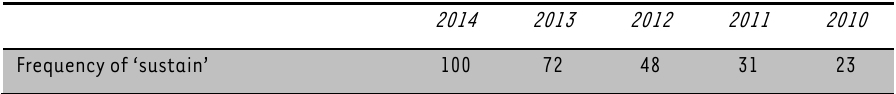
TABLE 5: SPAR sustainability frequencies from 2010 to